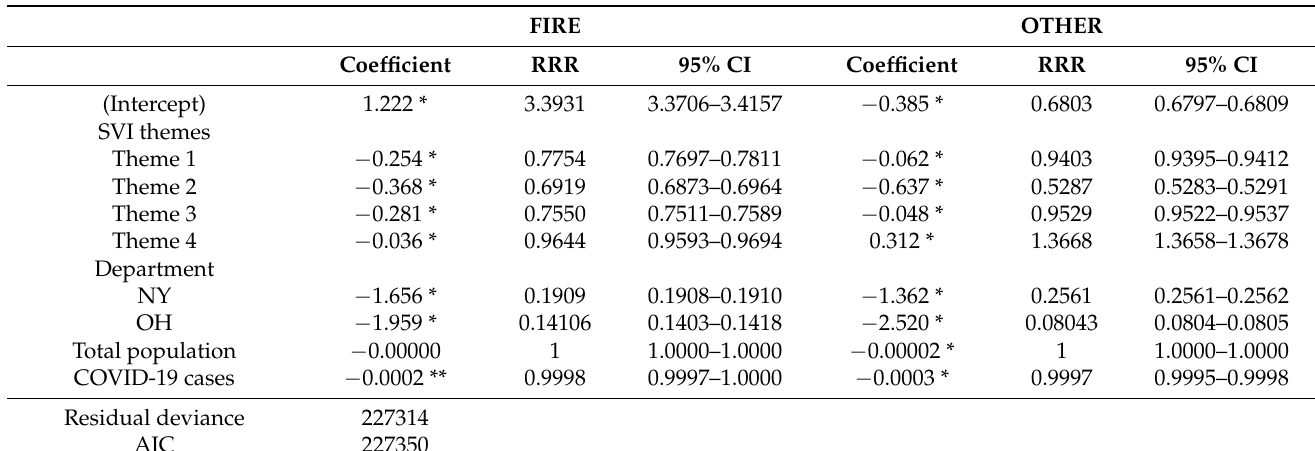
Table 6. Multinomial logistic regression